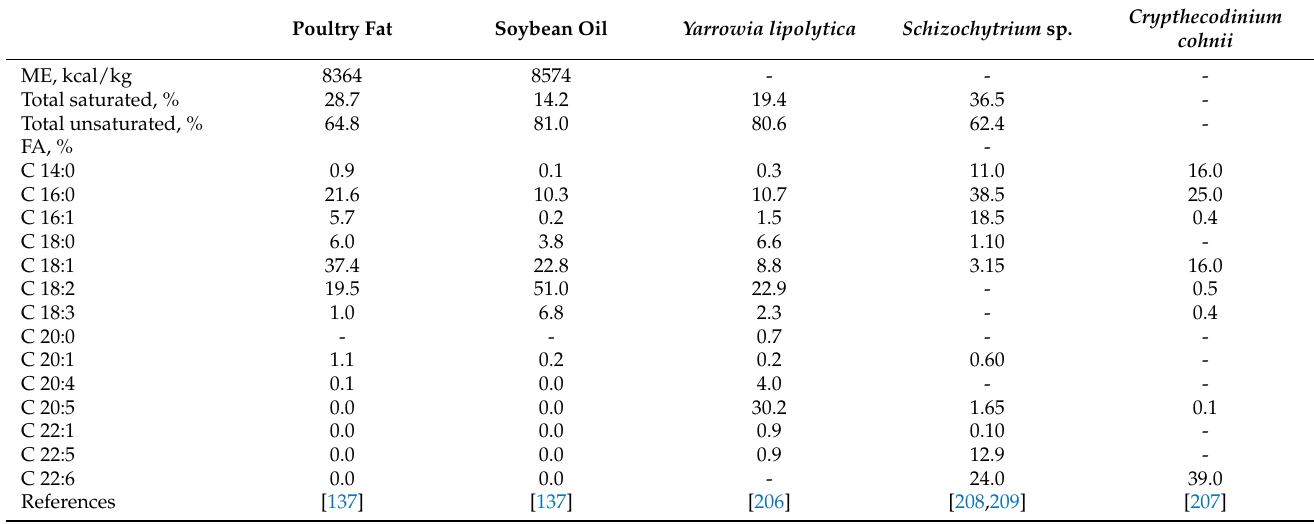
Table 9. Fatty acid composition (% of total lipids) in different sources of lipid supplements.